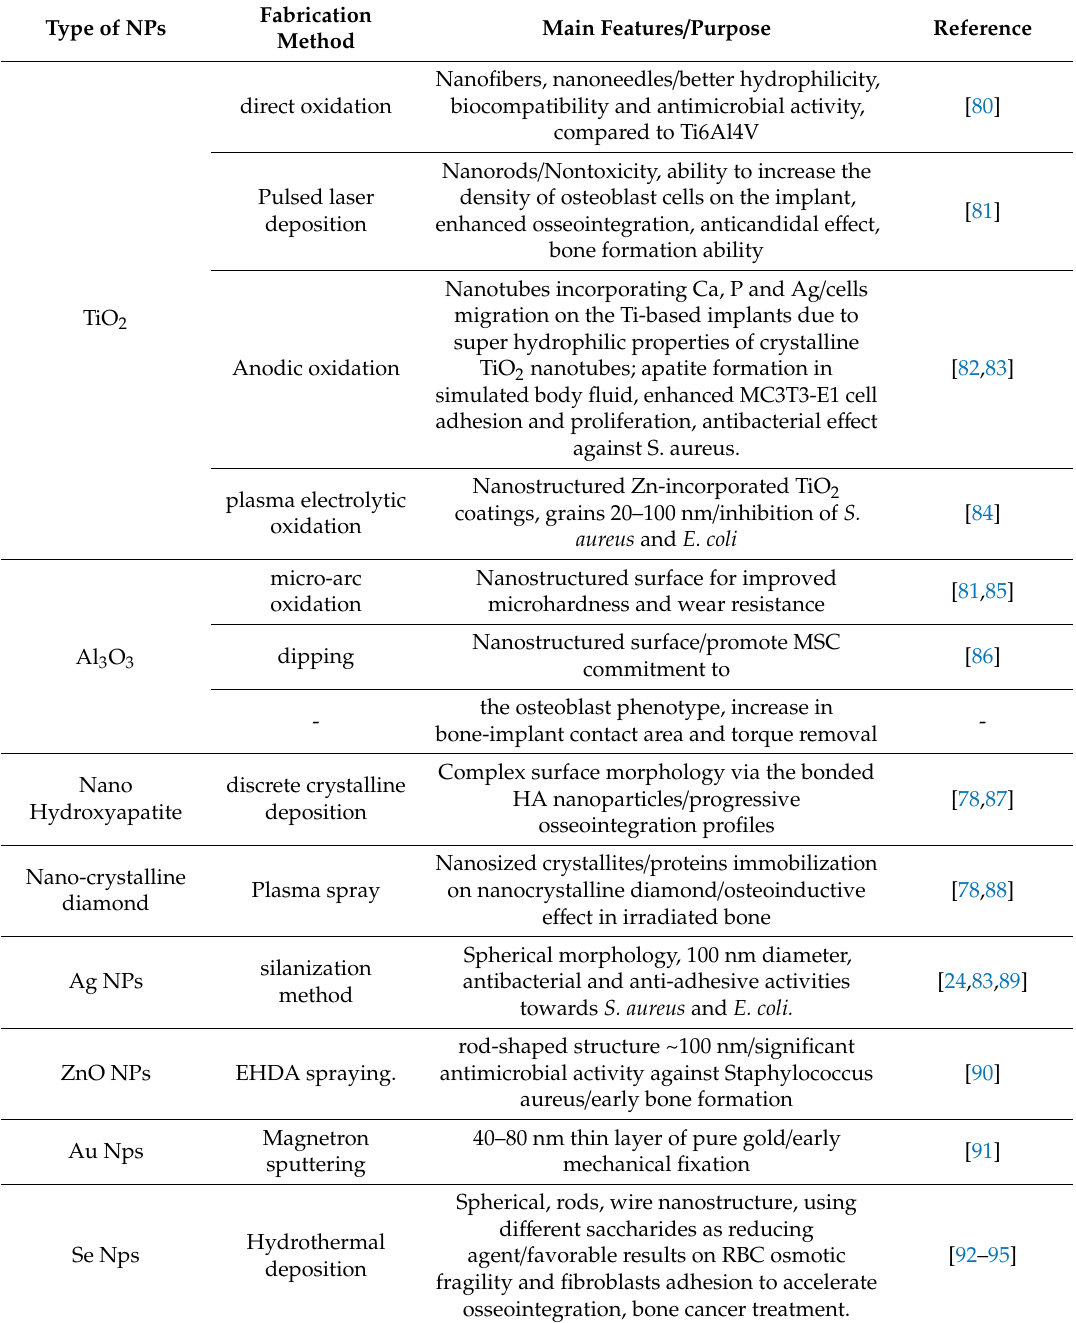
Table 2. Nanoparticles used for surface modification of Ti